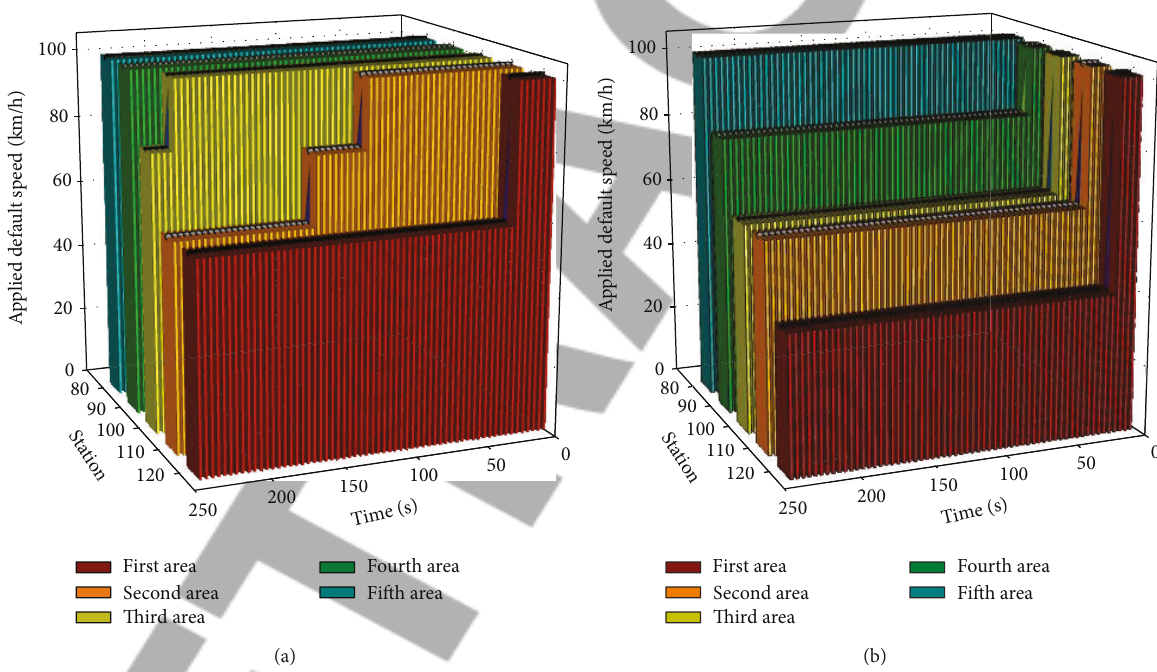
Figure 18: (a) Reaction time of VSL for applying the speed limits from the time of occurrence of the incident. (b) Reaction time of IASLD for applying the speed limits from the time of occurrence of the